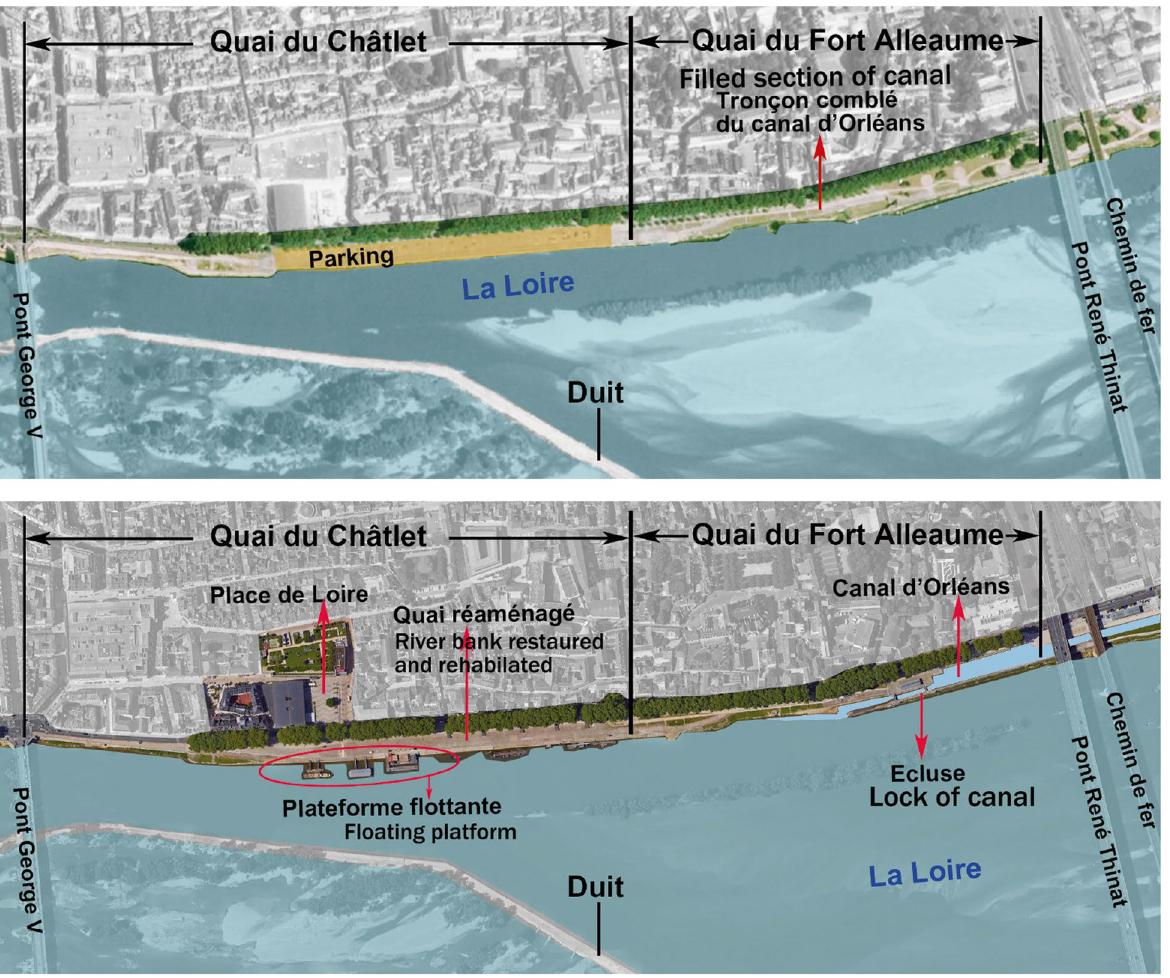
Fig. 12 Top: Public spaces on the quays along the Loire between the George V Bridge and the René Thinat Bridge, Historic centre of Orléans, 2002. Bottom: City riverbanks after the restoration and rehabilitation project, 2016 (Source: Peng 2020). Background map: Google Earth